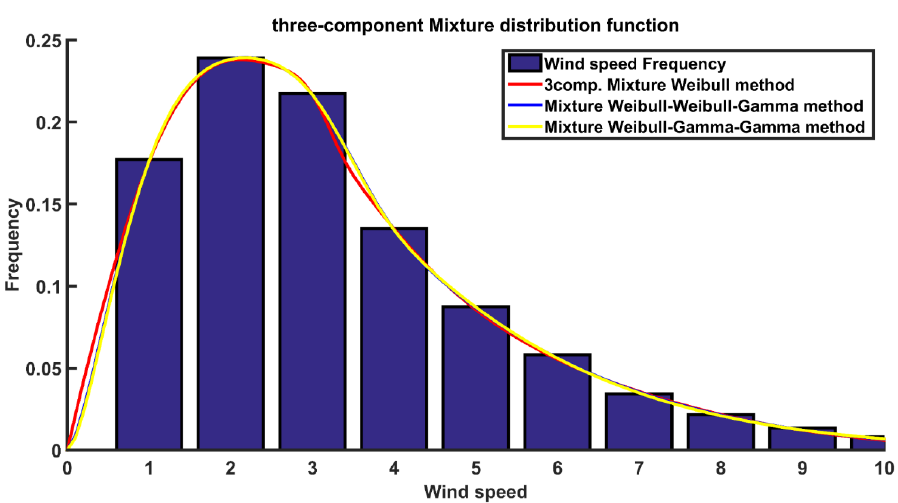
Table 3. Probability distribution parameters for the three-component mixtures of PDFs in wind speed modeling.